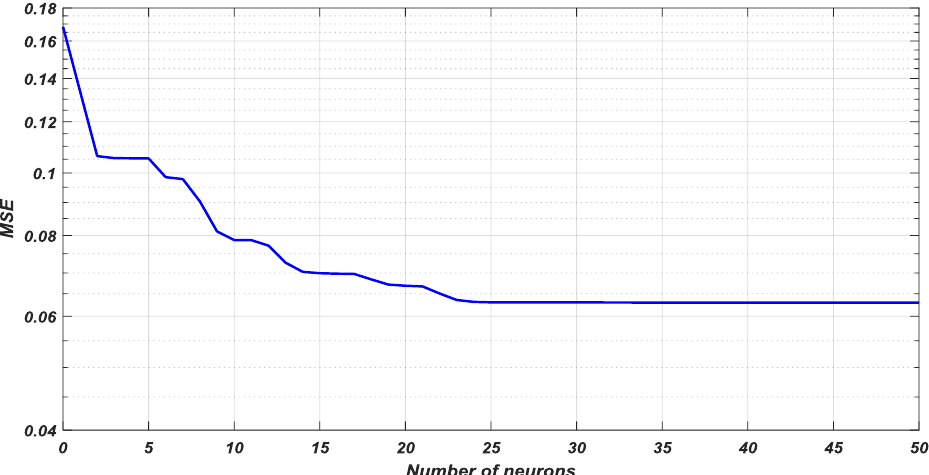
Figure 8. MSE versus the number of hidden layer’s neurons for determining the best structure of the network